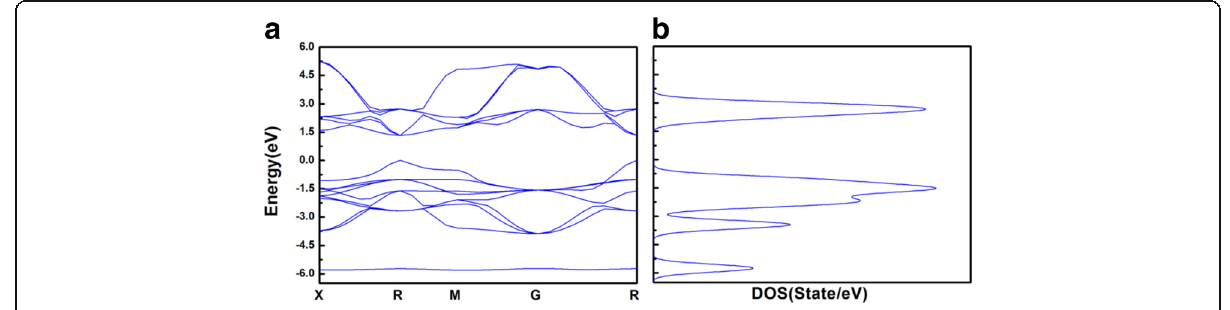
Fig. 1 a – b The band structure and density of states of TlPbI 3